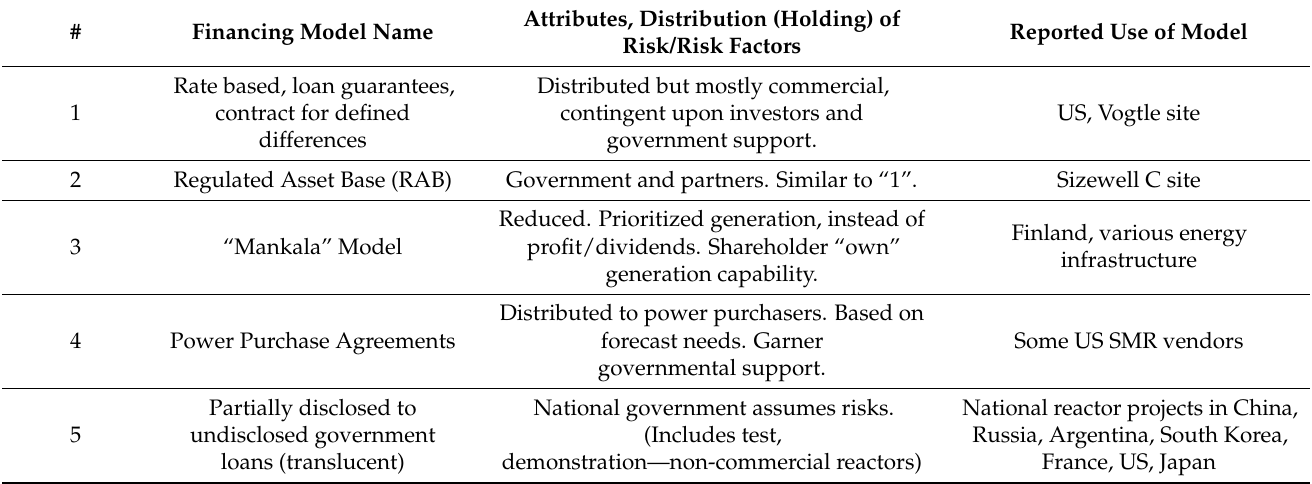
Table 3. Summary of approximate nuclear financing models in recent